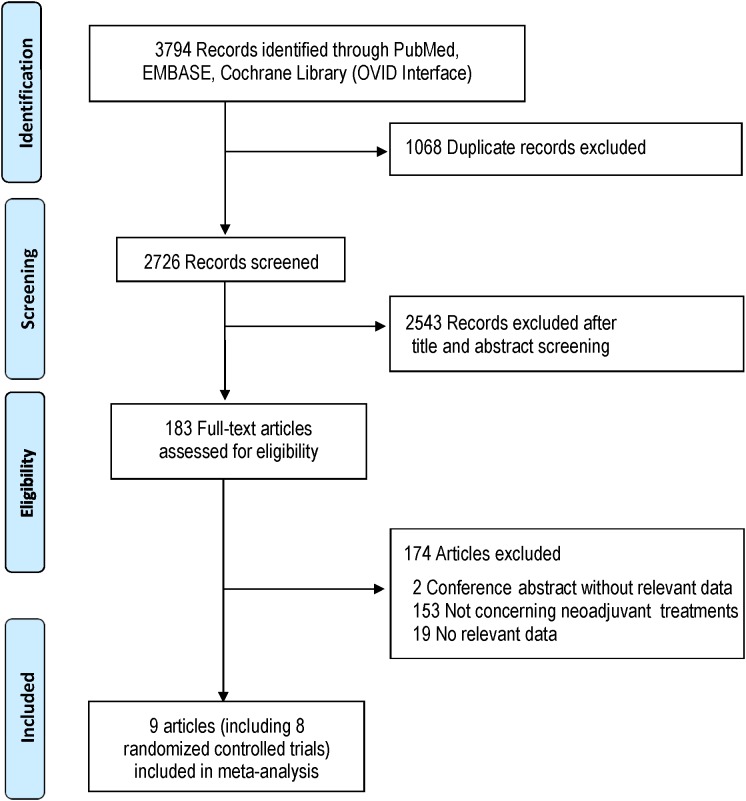
Study flow diagram.